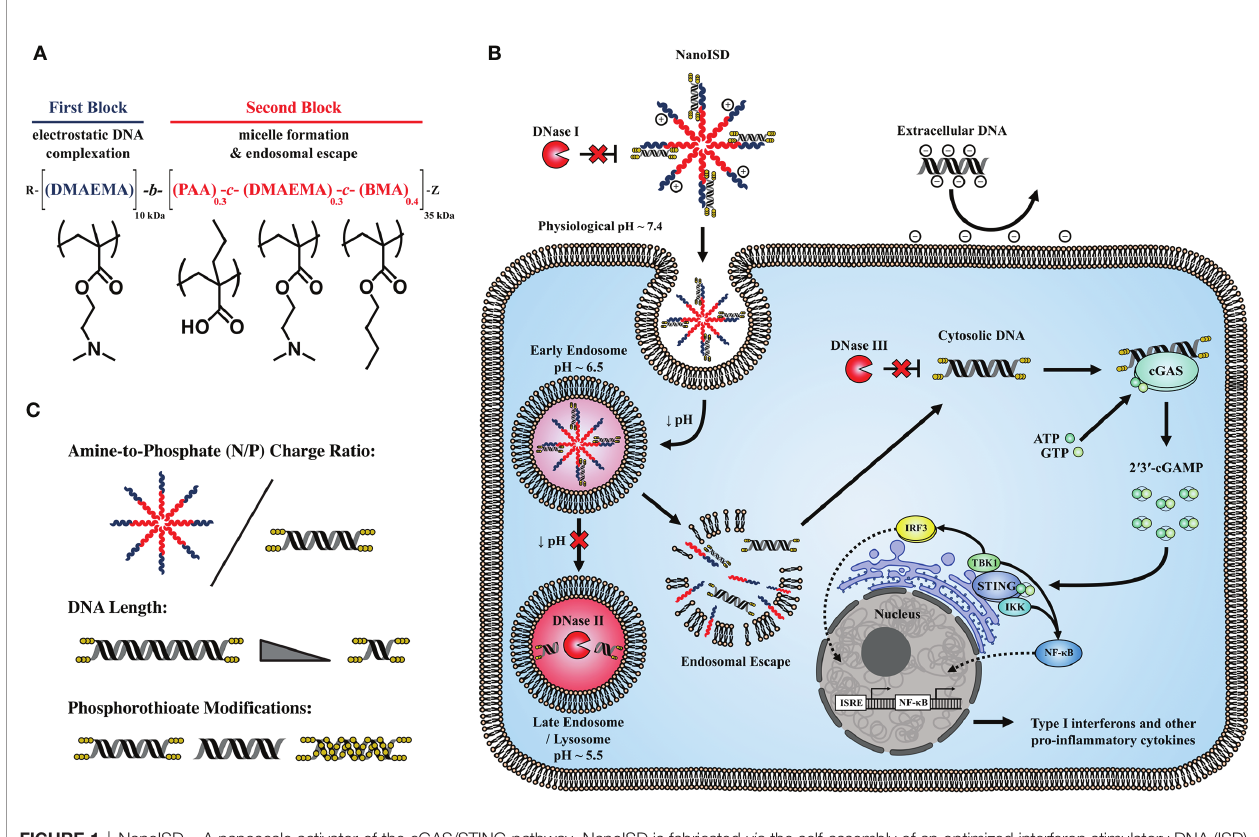
FIGURE 1 | NanoISD – A nanoscale activator of the cGAS/STING pathway. NanoISD is fabricated via the self-assembly of an optimized interferon stimulatory DNA (ISD) sequence in complex with endosome-destabilizing polymer nanoparticles. (A) Chemical composition of poly[(DMAEMA)- block -(PAA- co -DMAEMA- co -BMA)] (D-PDB). (B) Schematic representation of NanoISD activating cytosolic cGAS by evading major deoxyribonuclease and mediating cellular uptake and endosomal escape. (C) Design variables explored for DNA/polymer complexes include N/P charge ratio, dsDNA length, and degree and location of phosphorothioate backbone modi fi